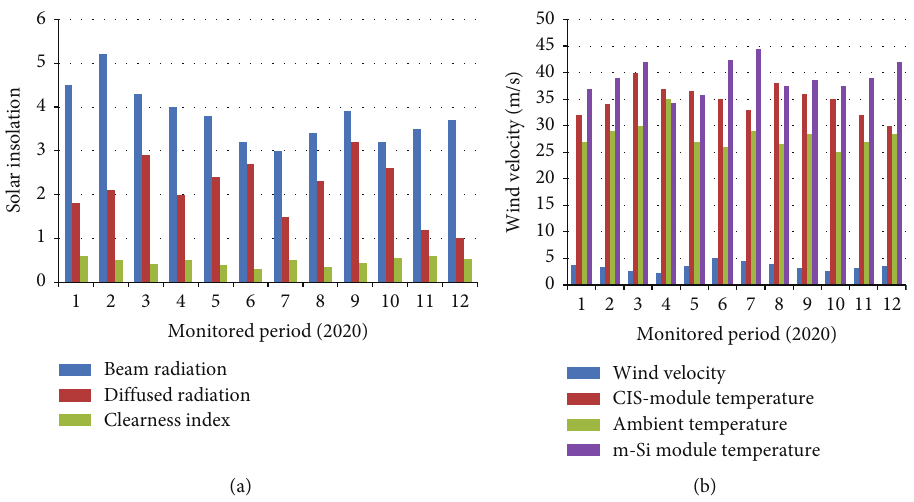
Figure 3: Monthly meteorological data. (a) Clearness index and mean global solar-radiation and (b) variations in module temperature, wind velocity, and ambient temperature. Table 5: Solar-radiation and clearness